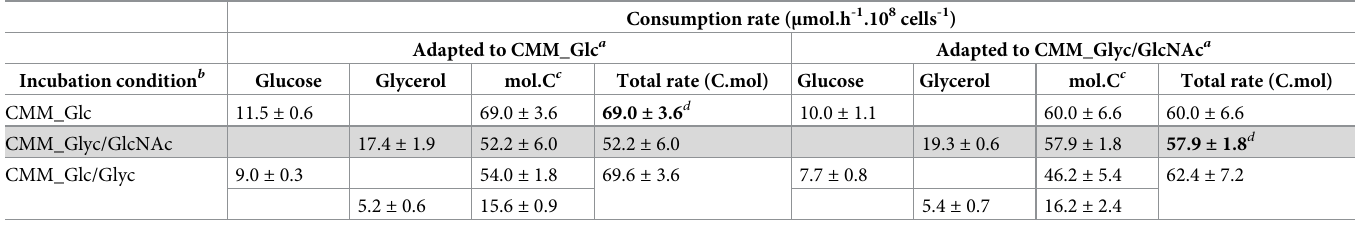
Table 1. Rate of glucose and glycerol consumption in BSF adapted to CMM_Glc or